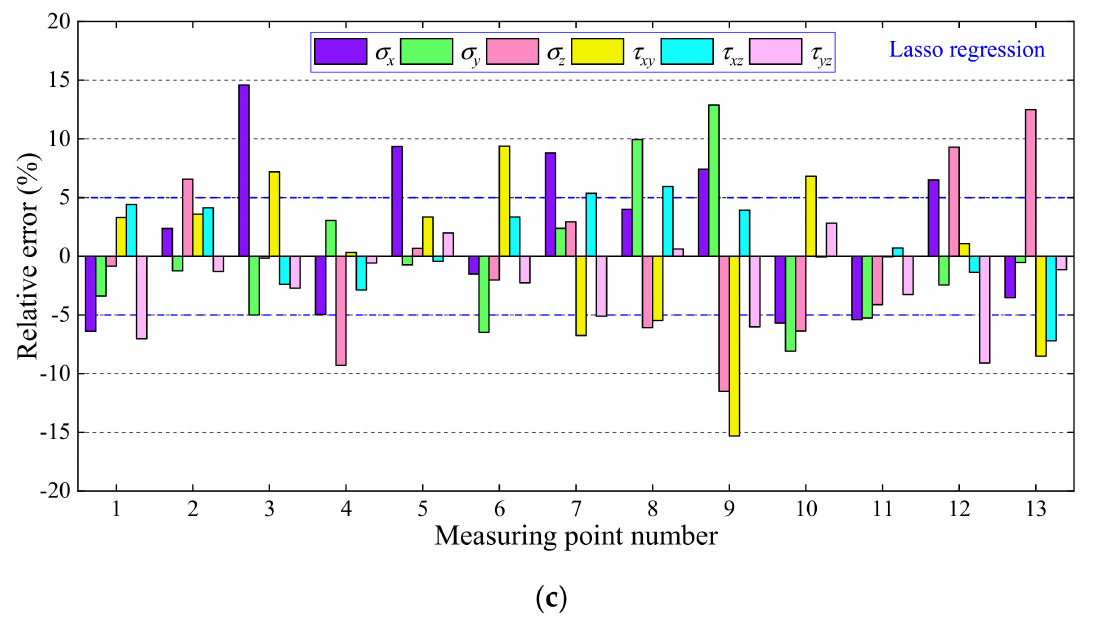
Figure 4. Relative error between the regression value and the measured value of different measuring points. ( a ) OLS; ( b ) RR; ( c ) LR. Table 7. Error comparison of regression results of three coefficient estimation